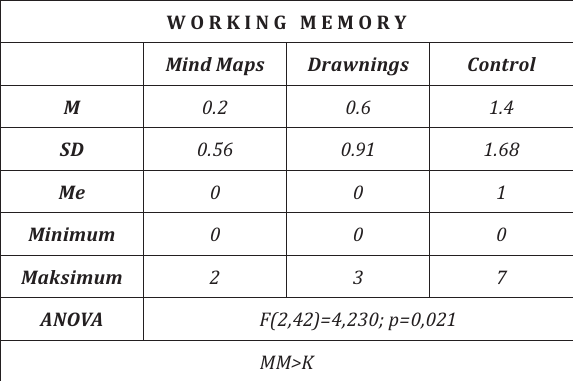
Table 3. Comparison of average results for the working memory variable in the second